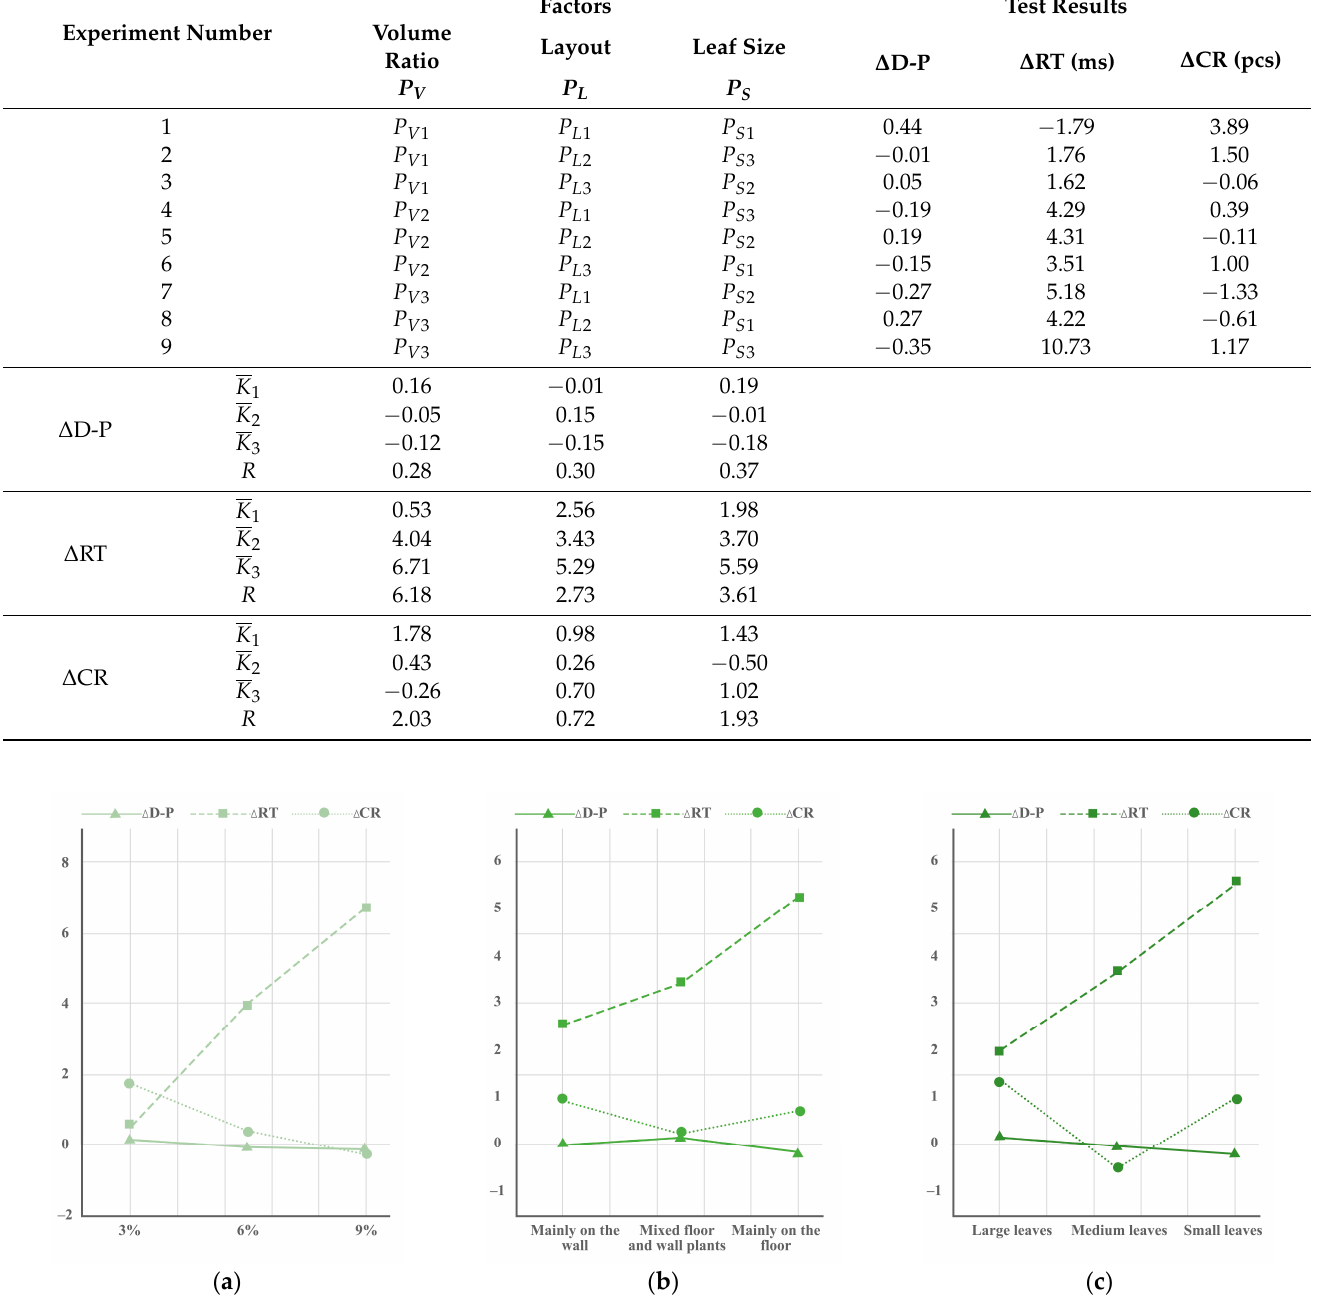
Table 5. Results of analysis of variance.